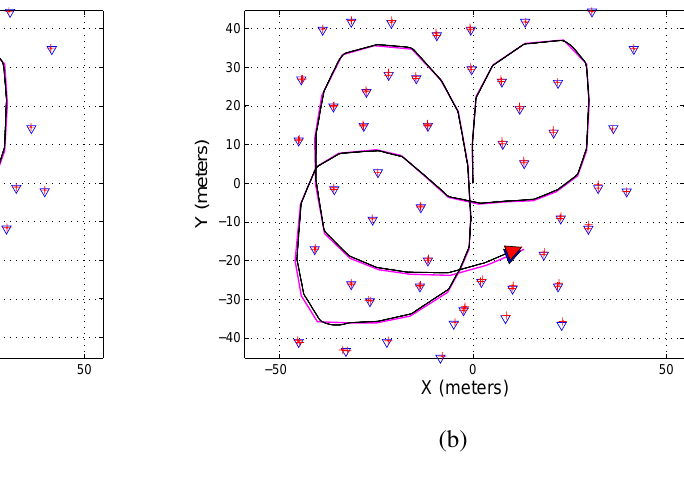
Figure 6. Map reconstruction of the environment using the covariance ratio feature selection criterion on the EKF-SLAM. (a) Shows the map reconstruction when the five most significant features — LIM = 5 in Algorithm 3—were used for the correction stage of the EKF-SLAM; (b) shows the map reconstruction when LIM = 2 . The path traveled by the mobile robot is represented in a solid black line and the path estimated by the SLAM in solid magenta; the features are represented by blue triangles and the ellipses of uncertainty associated with each feature are in solid